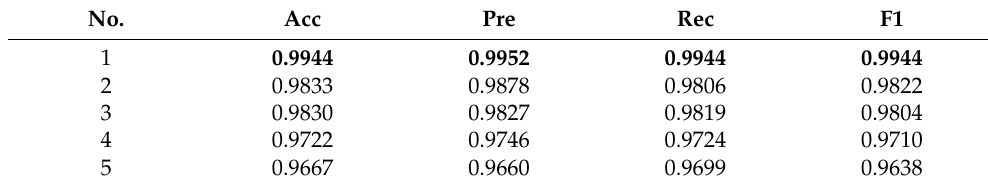
Table 6. Personalizing model—GXBoost three-level stress classification (top five individuals).